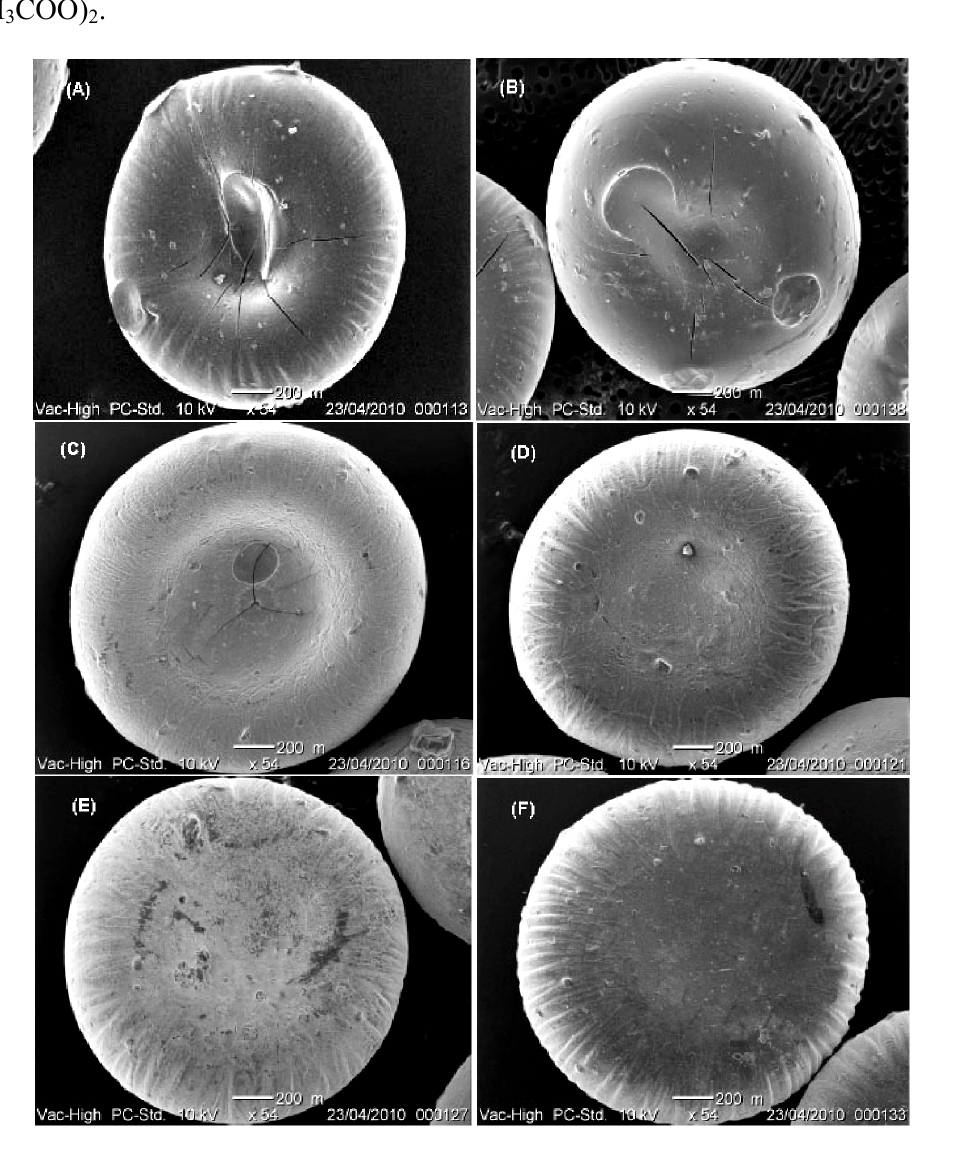
Figure 1. Scanning electron micrographs of MSKE-loaded pectinate beads (×54). ( A )